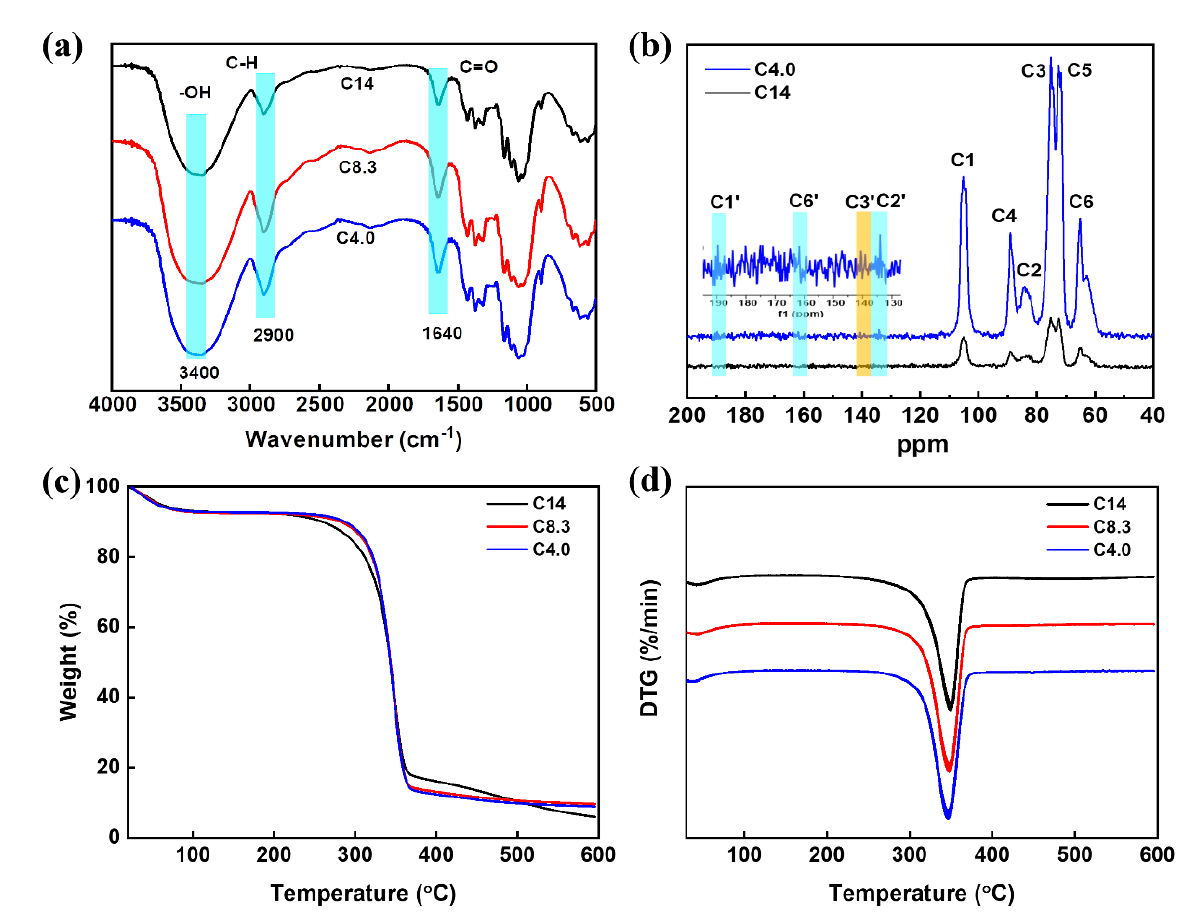
Figure 3. ( a ) FT-IR spectra of untreated (C14) and treated (C8.3 and C4.0) bamboo pulps. ( b ) Solid-state 13 C CP/MAS NMR spectrum of untreated (C14) and treated (C4.0) bamboo pulps. The curves of TGA ( c ) and DTG ( d ) of untreated (C14) and treated (C8.3 and C4.0) bamboo pulps under a nitrogen atmosphere.